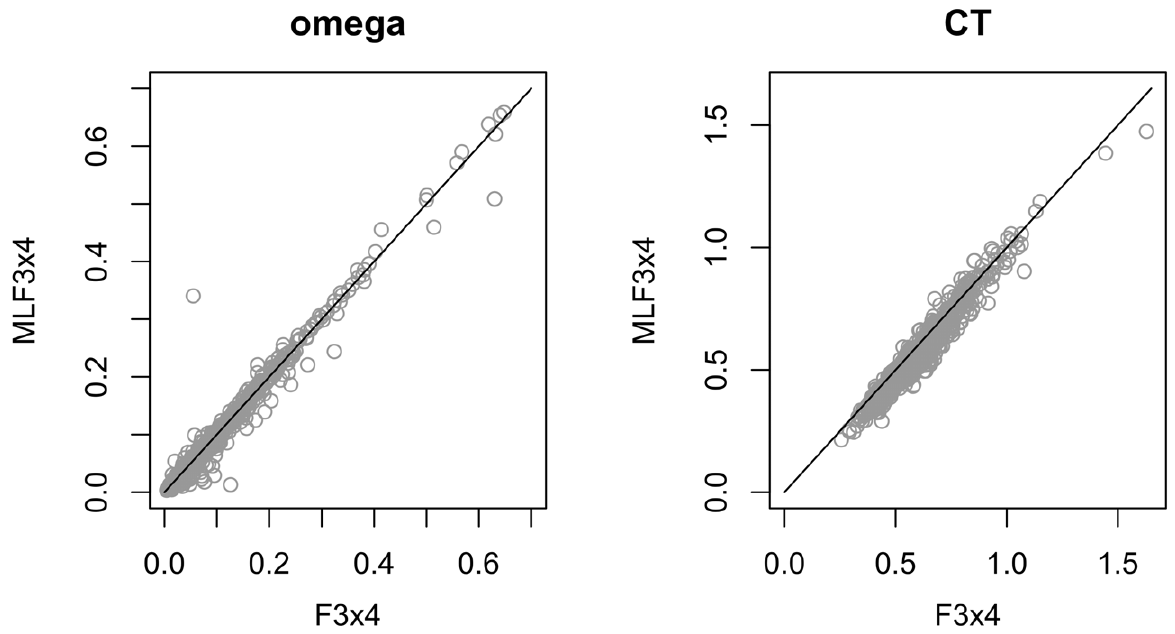
Figure 3. The effect of the frequency estimator on the inference of v and h CT (relative to the h AG rate) substitution rate from 856 alignments sampled from the Pandit database [ 10 ] . The estimate of h CT under F 3 | 4 is biased downwards relative to MLF 3 | 4 .